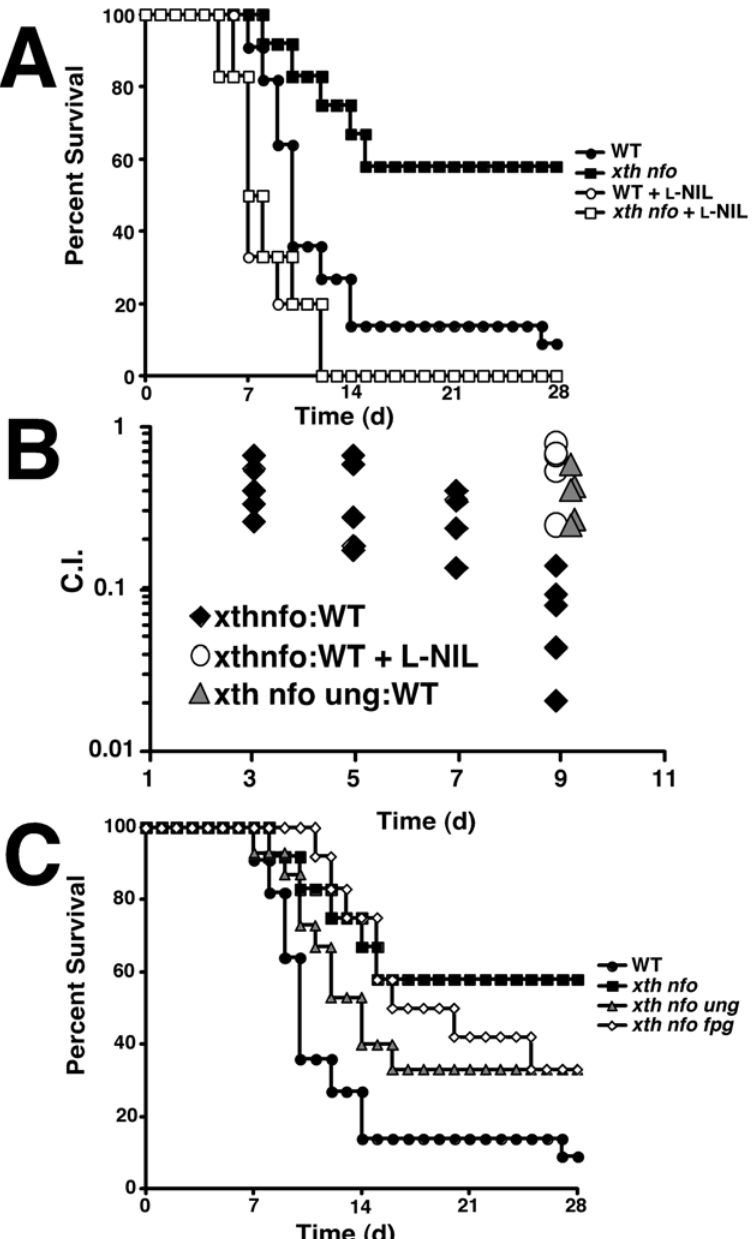
Figure 2. The attenuation of xthnfo mutant S. Typhimurium is due to NO ? –mediated base damage. (A) Full virulence can be restored to xth nfo S. Typhimurium (14028s) in C3H/HeN mice by administration of the NOS2 inhibitor L-NIL. (B) Livers were harvested from female C3H/HeN infected with a mixed inoculum of Wild Type and mutant S. Typhimurium at indicated days. Ratios of mutant to Wild Type viable cfu ? g 2 1 were determined and C.I.=Mutant OUT :WT OUT /Mutant IN :WT IN . (C) The attenuation of xth nfo S. Typhimurium is suppressed by further inactivation of DNA glycosylases ung and fpg